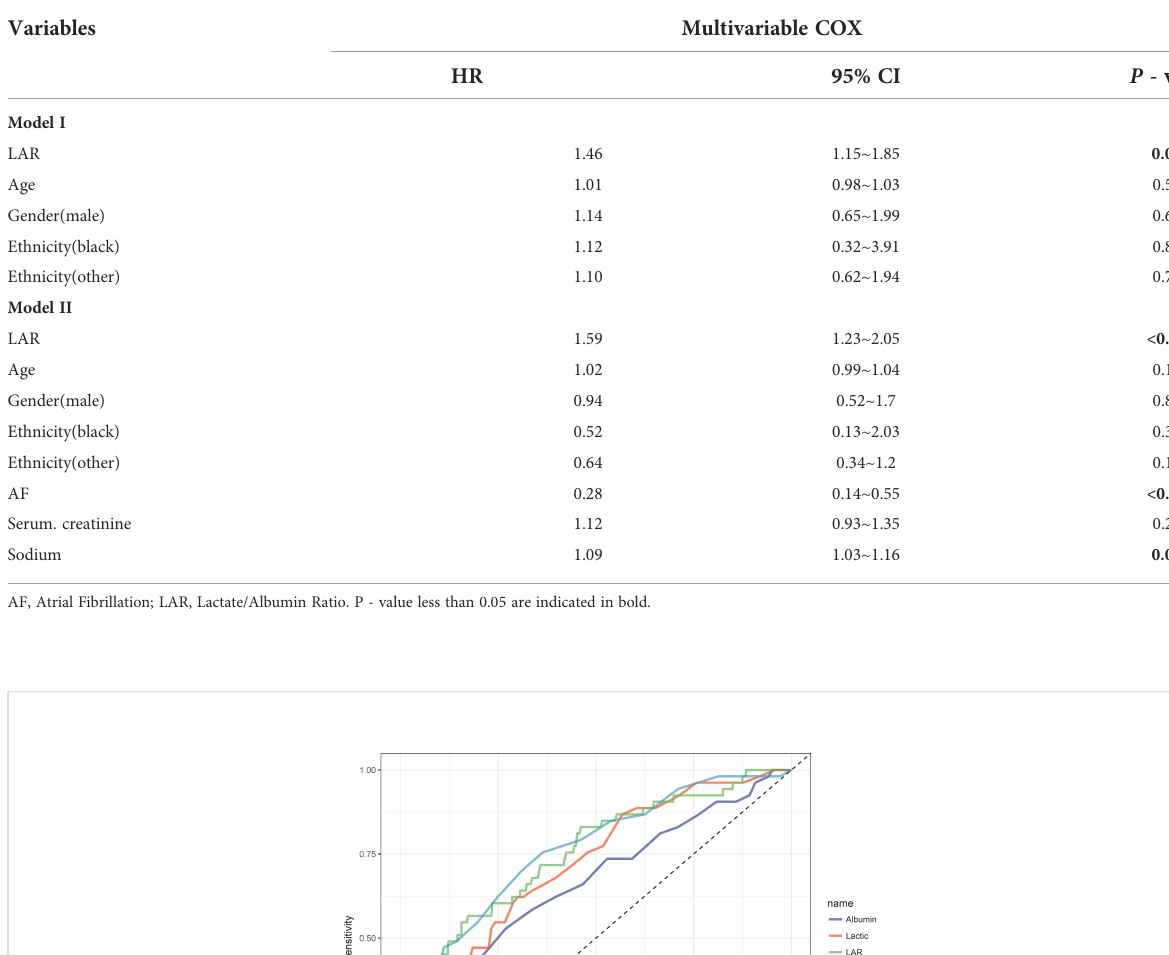
TABLE 3 Multivariate COX analysis of risk factors for death in patients within 28-d by logistic regression analysis.